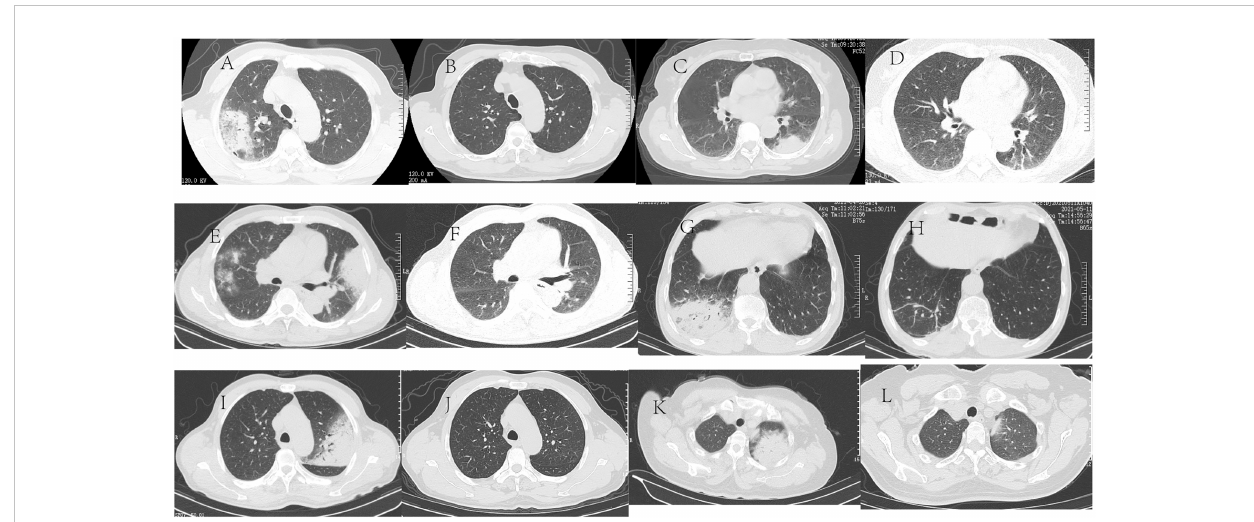
FIGURE 1 Chest CT of six patients with C psittaci pneumonia. Case 1: A 68-year-old male was admitted because of a fever and headache for three days. (A) Chest CT shows a patchy high-density shadow subpleural region in the right upper lung, with a small amount of pleural effusion in the right pleural cavity. (B) Two months after discharge from the hospital, chest CT showed that the in fl ammation in the upper lobe of the right lung almost disappeared. Case 2: A 69-year-old female was admitted because of a fever for two days. (C) Chest CT shows patchy and mass high-density shadow in the upper and lower lobes of the left lung, with a sign of an air bronchogram. (D) Two months after discharge from the hospital, chest CT showed that the lesions in the upper and lower lobes of the left lung almost disappeared. Case 3, A 51-year-old male was admitted because of left-sided chest pain with a fever for three days. (E) Chest CT shows bilateral multiple patchy and mass high-density shadows, accompanied by local consolidation and air bronchogram sign with a small amount of bilateral pleural effusion. (F) One month after discharge from the hospital, chest CT showed that the in fl ammation in the bilateral lungs disappeared. Case 4: A 69-year-old male was admitted because of a fever for seven days. (G) Chest CT shows a patchy high-density shadow in the lower lobe of the right lung, with local consolidation and air bronchogram sign. (H) One month after discharge from the hospital, chest CT showed that the in fl ammation in the lower lobe of the right lung disappeared. Case 5: A 63-year-old male was admitted because of a cough and fever for ten days. (I) Chest CT shows a large patchy high-density shadow in the left upper lung, with local consolidation; A few consolidation shadows in the left lower lung and a small amount of fl uid in the left pleural cavity. (J) Two months after discharge from the hospital, chest CT showed that the in fl ammation in the upper lobe of the left lung almost disappeared. Case 6<nbsp/>A 58-year-old female was admitted because of a fever for four days. (K) Chest CT shows a mass high-density shadow in the left upper lung, with consolidation and air bronchogram sign. (L) One month after discharge from the hospital, chest CT showed that the in fl ammation in the upper lobe of the left lung